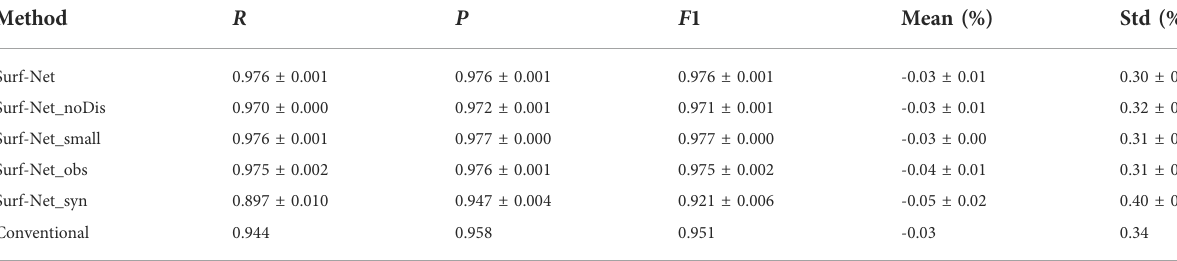
TABLE 3 Performance of average picks in the observational test set. The threshold is set to 1%.